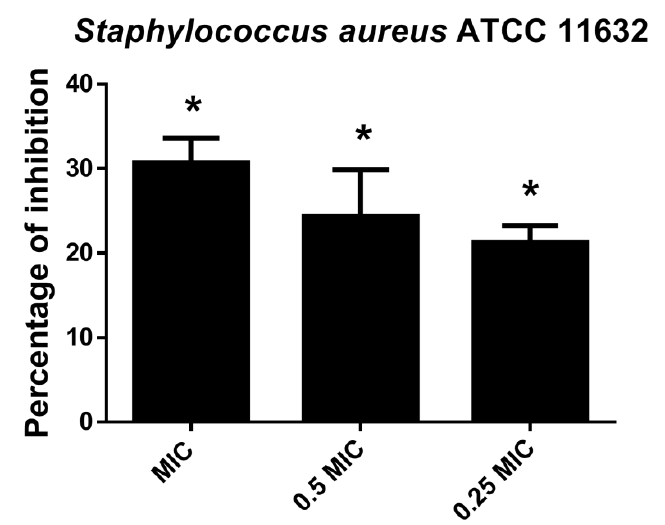
Figure 5. Inhibition of biofilm formation in S. aureus ATCC 11632 after application of hesperetin in concentrations 0.25 MIC (1 mg/mL), 0.5 MIC (2 mg/mL) and MIC (4 mg/mL). Mean values of triplicate independent experiments ± SD are shown. * p < 0.05 compared to control.